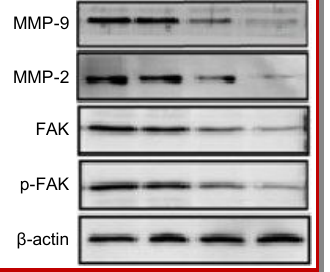
Figure 4: Inhibition of FAK, pFAK, MMP-2 and MMP-9 ex- pression in OVCAR5 cells by ludartin treatment. The cells after incubation with ludartin or DMSO (control) were subjected to western blot analysis using β - actin as internal control